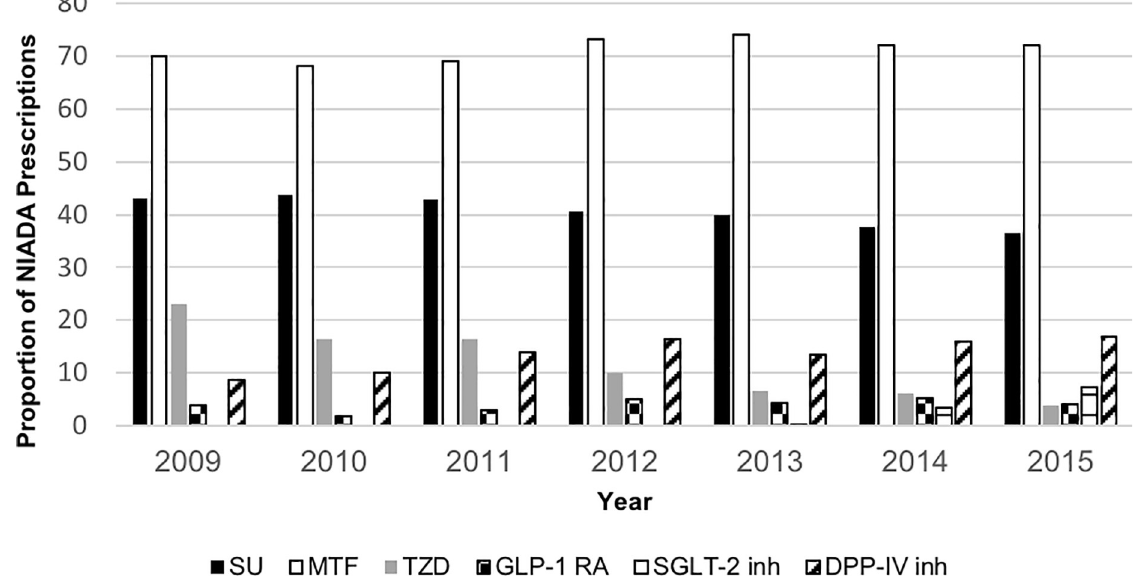
Fig 1. Non-insulin antidiabetic agent prescriptions 2009-2015. NIADA: Non-insulin antidiabetic agents.